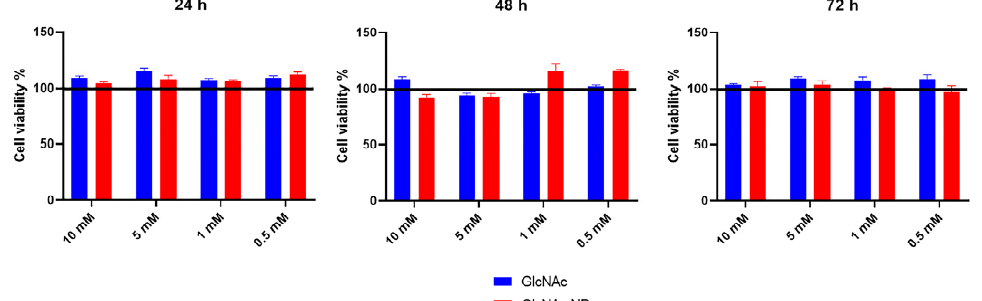
Figure 3. The MTS colourimetric method was performed to assess the cell viability of HPCs treated with four different concentrations of GlcNAc and GlcNAc NP (10 mM, 5 mM, 1 mM, and 0.5 mM), for 24, 48, and 72 h. Cell viability of treated samples was normalized to the untreated cells, which is reported as 100% and represented in the graphs by a black horizontal line.